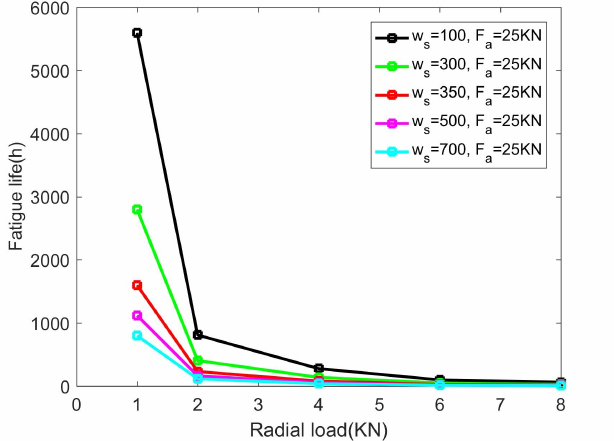
Figure 23. The fatigue life with different radial loads of case